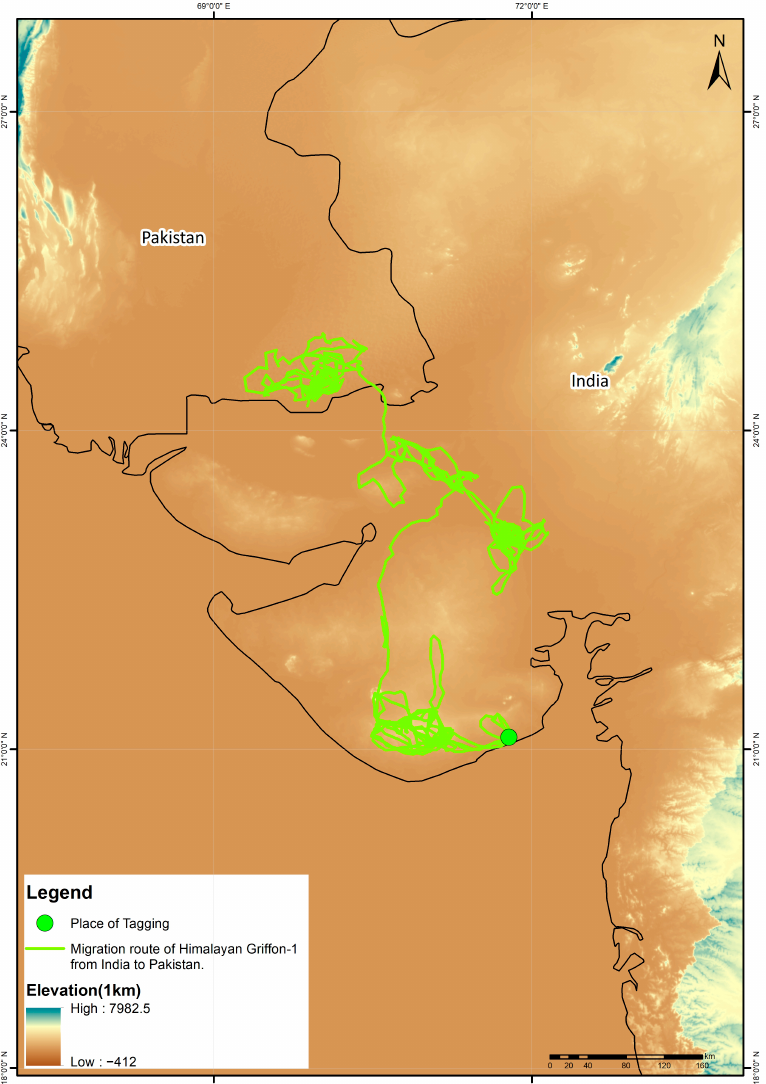
Figure 2. Migration route of Himalayan griffon-1 from Saurashtra Landscape (Gujarat). Green dot represents the place of tagging of Himalayan griffon-1. This map was generated using ArcGIS 10.8.1. Redlands, ESRI, Redlands, CA, USA. Country borders represented here are according to Google Earth imagery (Google India).